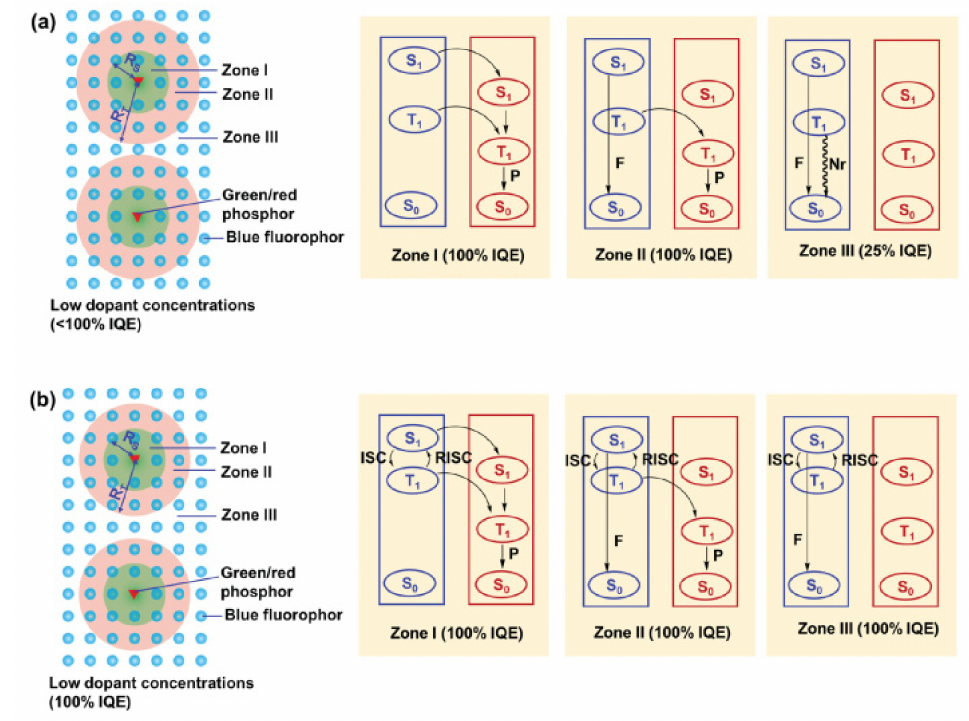
Figure 13. Schematic diagrams for management of singlet and triplet excitons in single-EML hybrid WOLEDs based on ( a ) conventional blue fluorophores and ( b ) TADF blue emitters with low dopant concentrations. Green circle coverage represents diffusion zone of singlets (Zone I). Pink circle coverage represents diffusion zone of triplets (Zone II). The uncovered zone is Zone III; for conventional blue fluorophores, all singlets and triplets formed in this zone cannot reach the phosphor molecules and only singlets can be used for emission; for TADF blue emitters, triplets can be up-converted into S 1 for emission together with the directly generated singlets. R S and R T are respectively diffusion lengths of singlet and triplet excitons; compared with conventional host, R T of TADF host is smaller due to the fast competition process of RISC. F, fluorescence; P, phosphorescence; Nr, nonradiative decay. Reproduced with permission from [162], John Wiley and Sons,